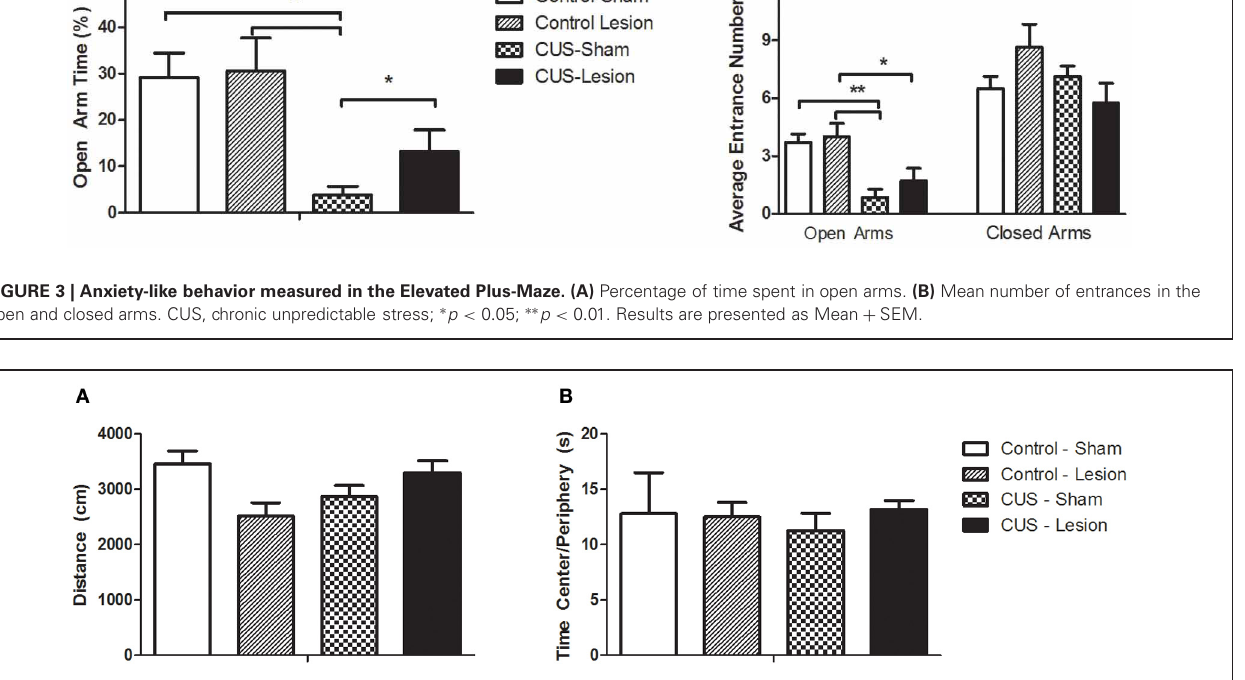
FIGURE 4 | Open field test. (A) Total distance ran in the open field test. (B) Ratio between time spent in center and periphery. No statistical differences were found between groups. CUS, chronic unpredictable stress. Results are presented as Mean + SEM.